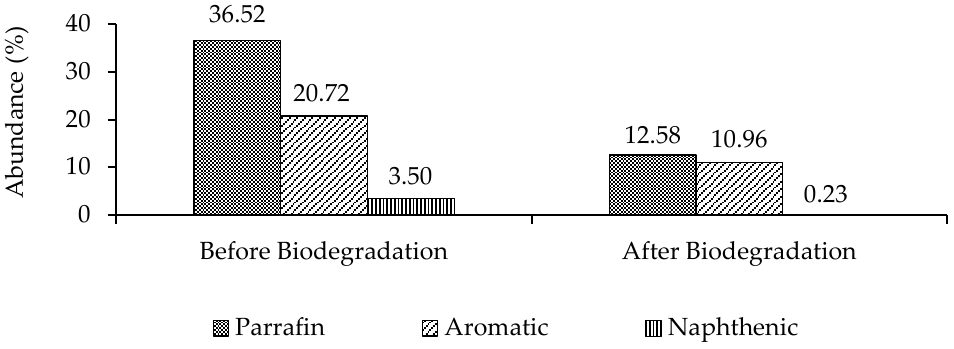
Figure 6. GC-MS showed the abundance of paraffinic, aromatic, and naphthenic compounds in the oil samples. Those entire components were degraded by the biodegradation process.